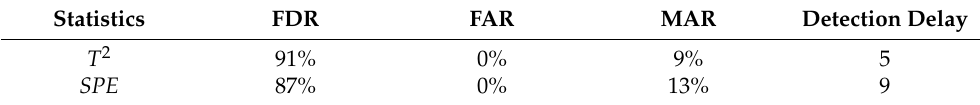
Table 2. TE simulation case online monitoring results.